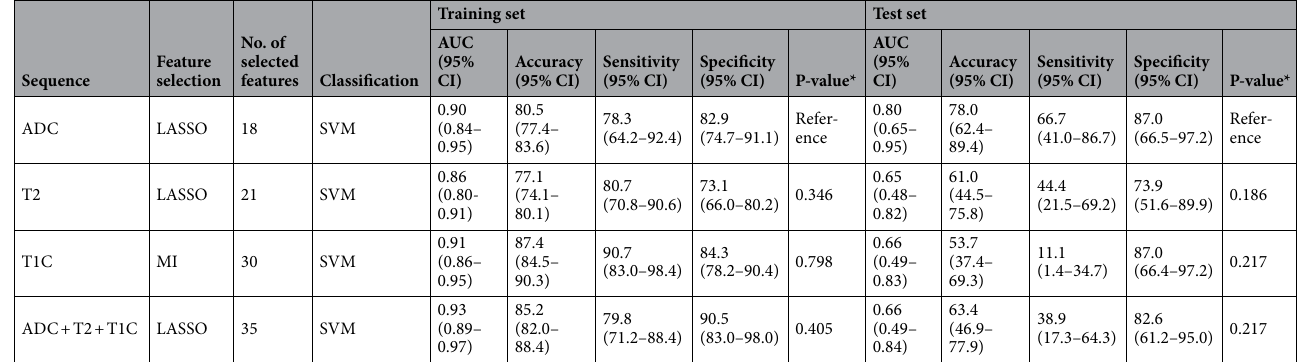
Table 2. Diagnostic performance of the best performing machine learning model in the training set and the test set. All training set performance was calculated on SMOTE generated datasets. CI confidence interval, LASSO least absolute shrinkage and selection operator, MI mutual information, SMOTE synthetic minority over-sampling technique, SVM support vector machine, T1C postcontrast T1WI, T2 T2WI. *P-value refers to the significance among the differences of the AUCs between the ADC radiomics model and the other